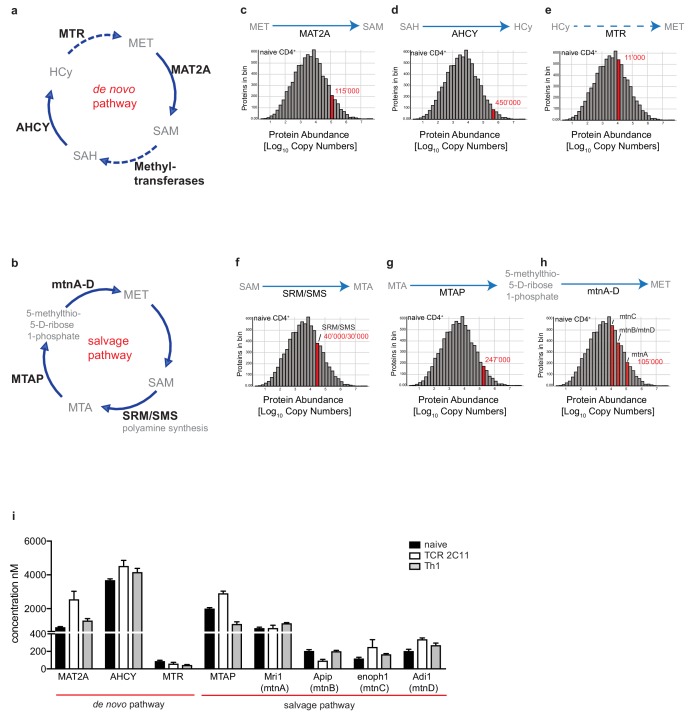
Proteomics expression of methionine pathway in T cells Quantitative proteomics data showing the abundance of key enzymes in the methionine cycle of the de novo.(a) and the salvage pathways (b). Mean protein copy numbers, indicated in red, estimated using the proteomic ruler protocol and presented as log-transformed mean values are shown relative to their frequency in the total data set. The graphs show copy numbers from naïve CD4+ T cells of MAT2A (c), AHCY (d), MTR (e) and SRM/SMS (f), MTAP (g) and mtnA-D (h). (i) Quantitative proteomics data comparing the concentration of key enzymes in the methionine cycle of the de novo and the salvage pathways in naïve, TCR activated and Th1 effector CD4+ T cells. Concentration is calculated using the histone ruler and estimated mass of molecules per cell, as described in Wiśniewski et al. (2014). (Data are from three biological replicates and error bars are mean ± s.d.).